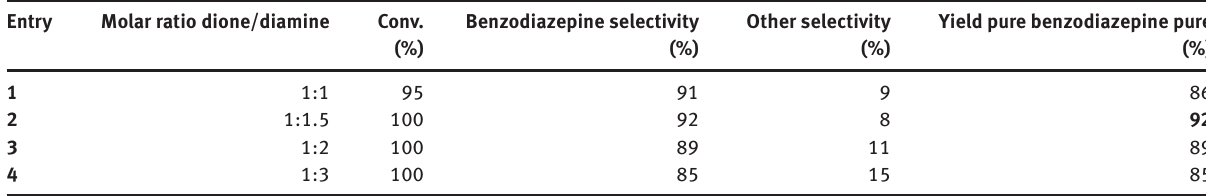
Table 6: Effect of substrate molar ratio for PVA 60-100. Entry Molar ratio dione/diamine Conv.